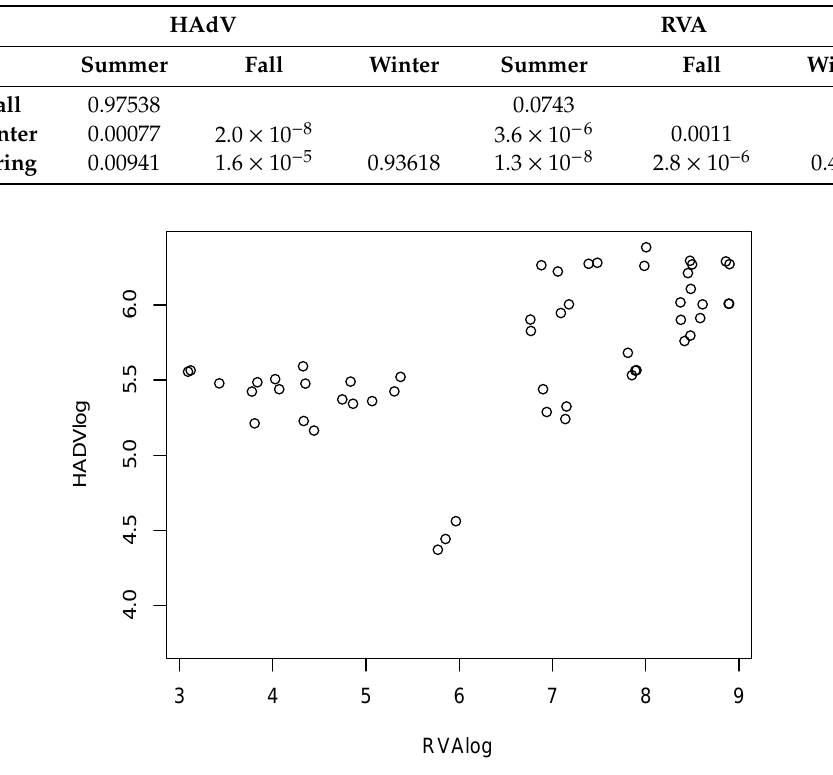
Table 2. Pairwise comparison analysis ( p -values) between viral load and season using the Tukey and Kramer (Nemenyi) test.